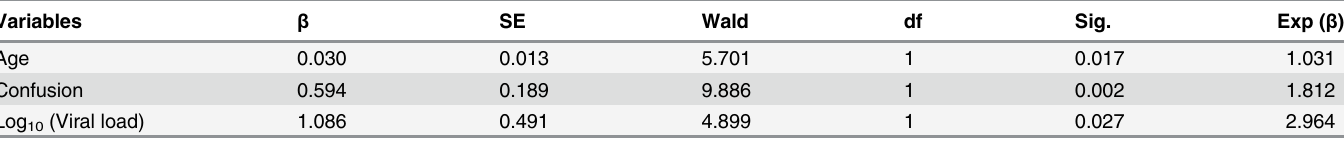
Table 2. Survival analysis using Cox proportional hazards